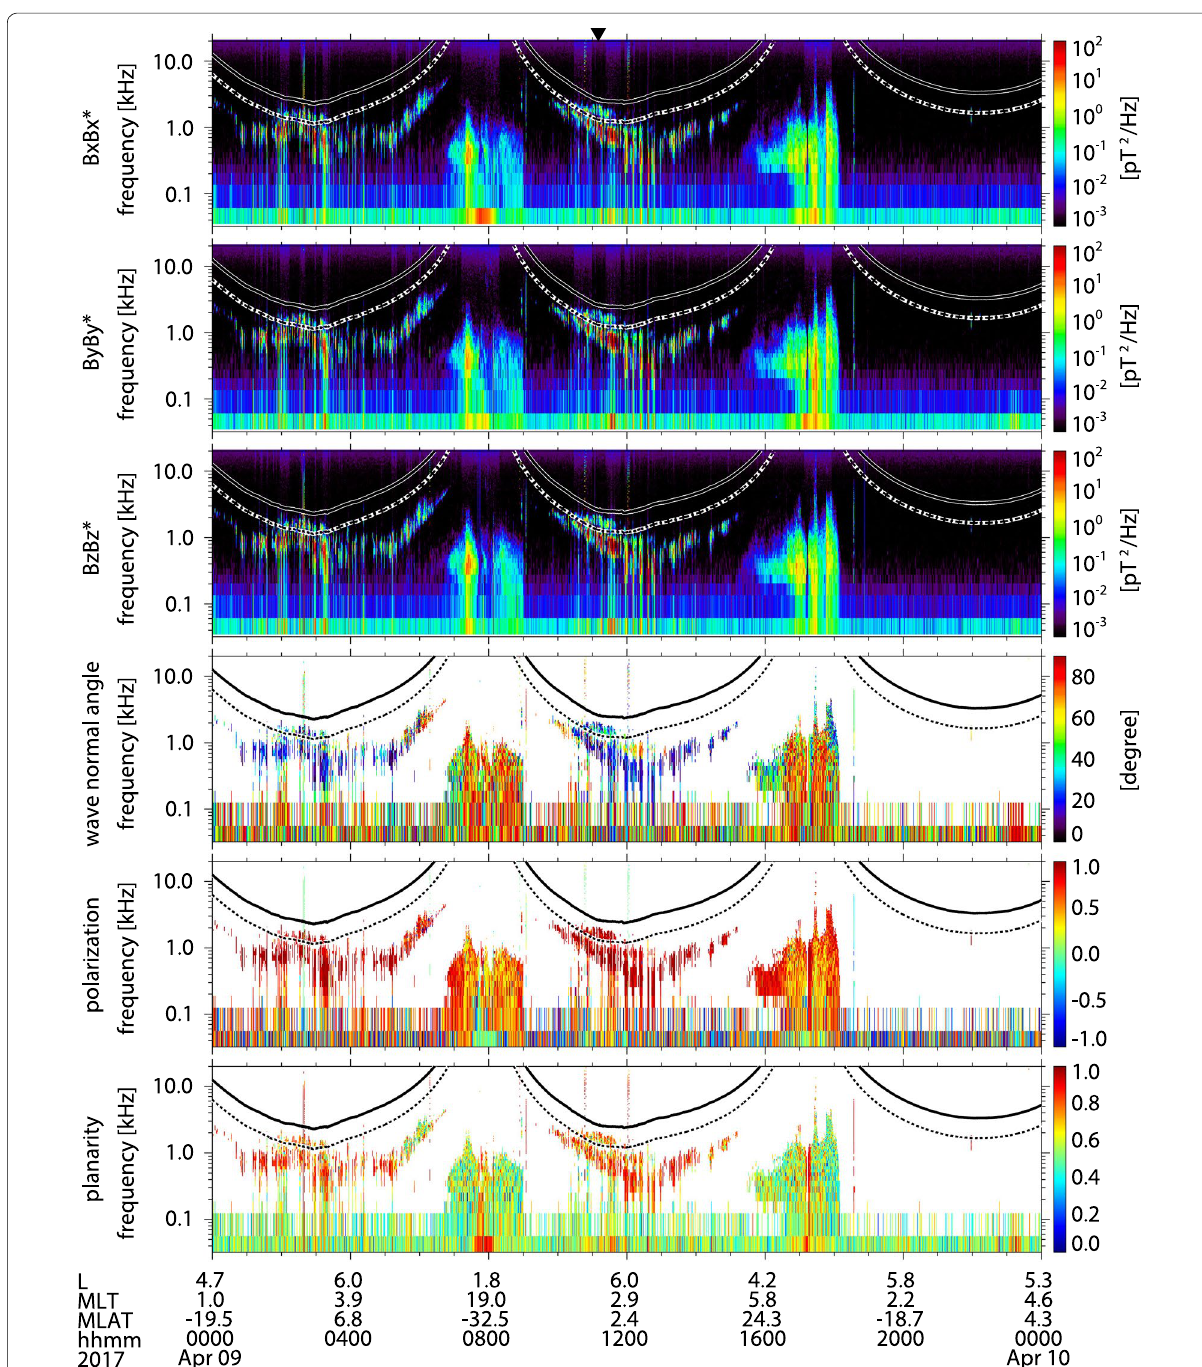
Fig. 18 An example of the wave propagation vector analyses by using data obtained by OFA-MATRIX(B) on April 09,